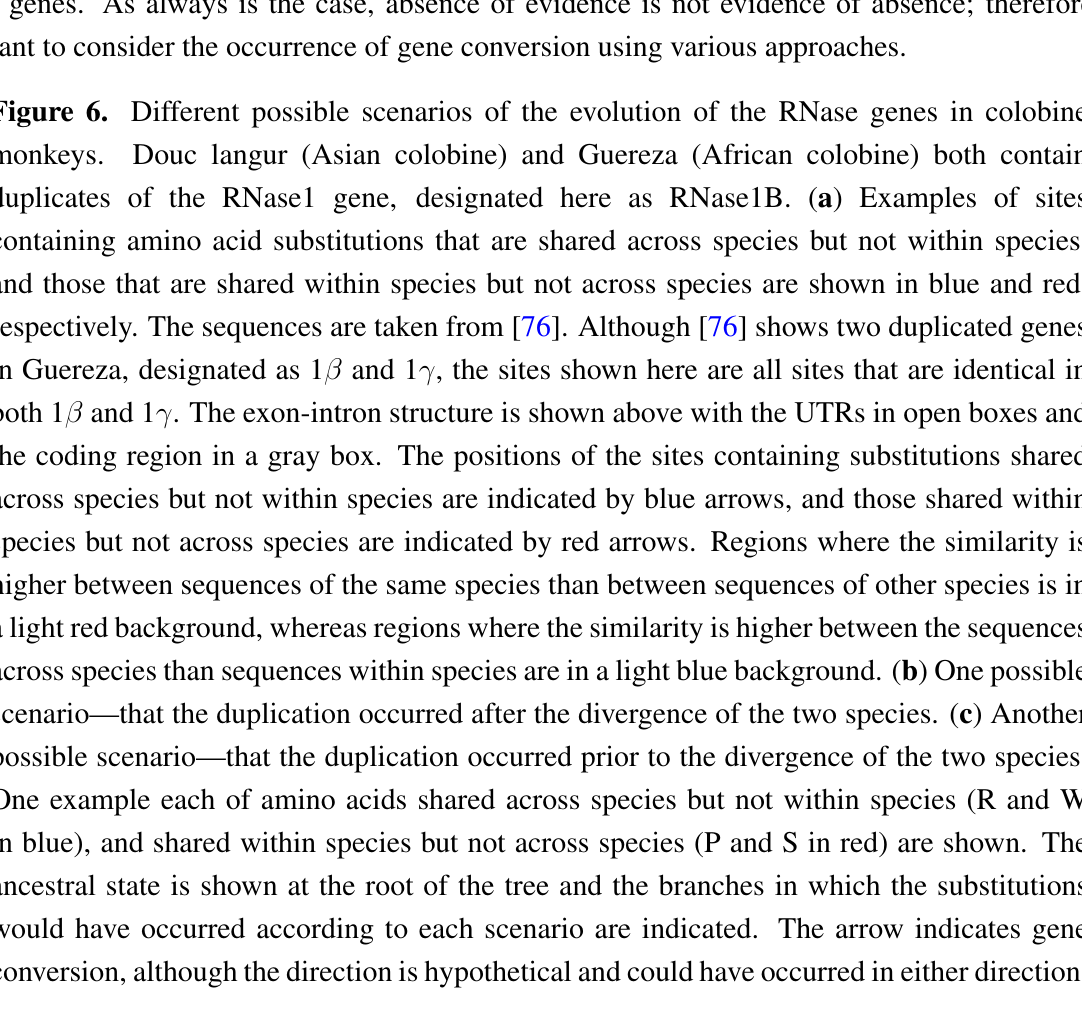
Figure 6. Different possible scenarios of the evolution of the RNase genes in colobine